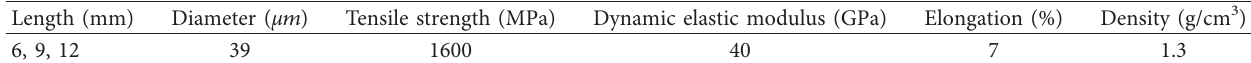
Table 2: The performance index of PVA fiber.